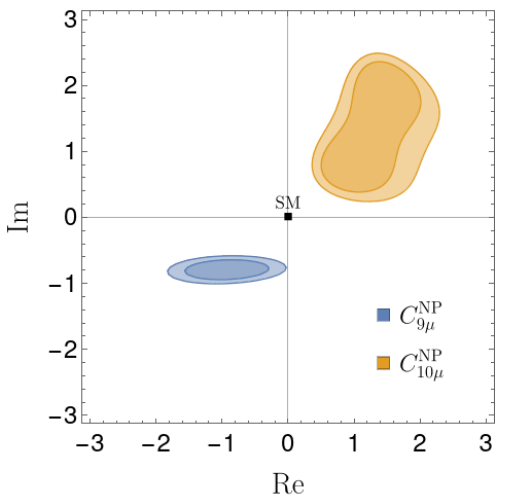
Figure 7 . Constraints on C 9 µ and C 10 µ in the complex plane assuming the input measurements and uncertainties given in (3.9). The lines show the 68% and 90% C.L.